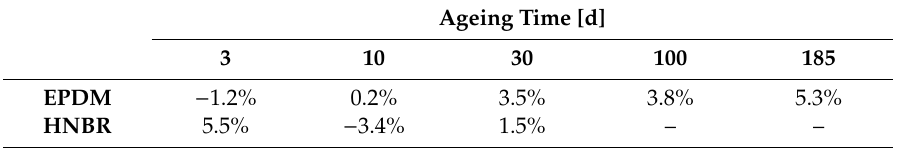
Table 1. Relative deviation between axial and radial normalized average compressive force.